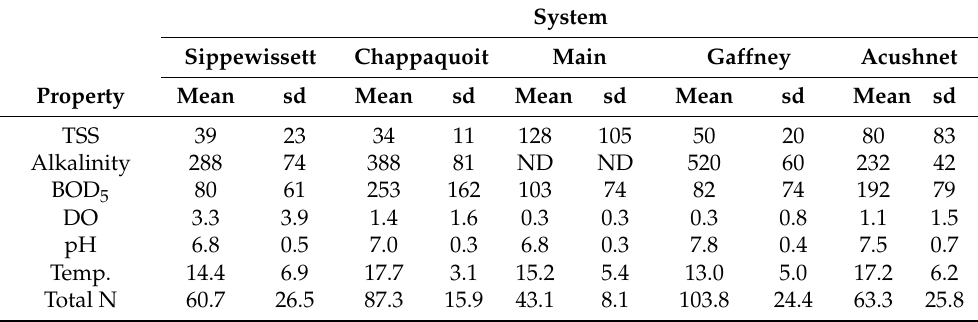
Table 2. Mean and standard deviation (sd) values of total suspended solids (TSS), alkalinity, 5–day biochemical oxygen demand (BOD 5 ), dissolved oxygen (DO), pH, temperature, and total N for field systems. Units are mg/L except for temperature ( ◦ C) and pH. ND = not determined. System Sippewissett Chappaquoit Main Gaffney Acushnet Property Mean